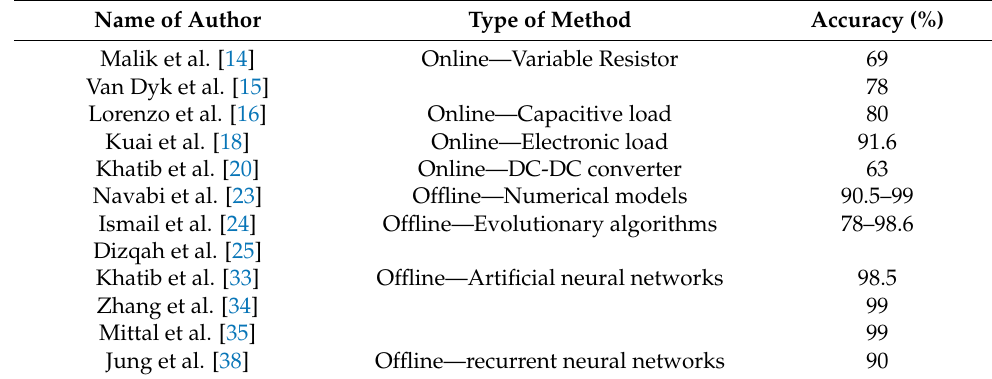
Table 1. The accuracy of some of the methods that extracted the IV curve or output